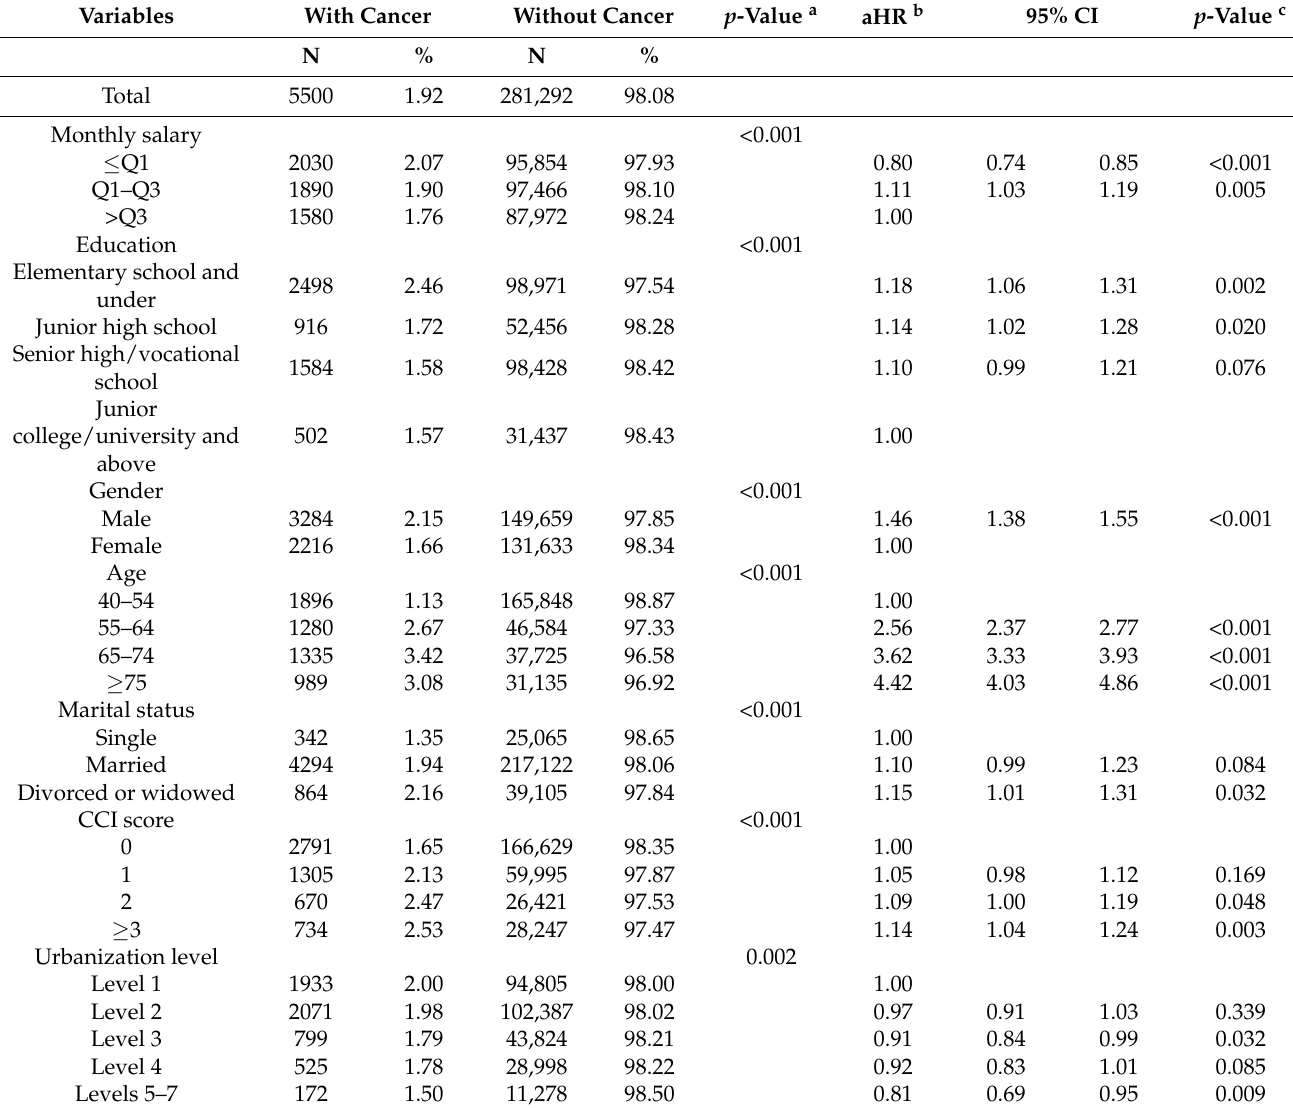
Table 2. Relative risks of suffering from colorectal cancer in study